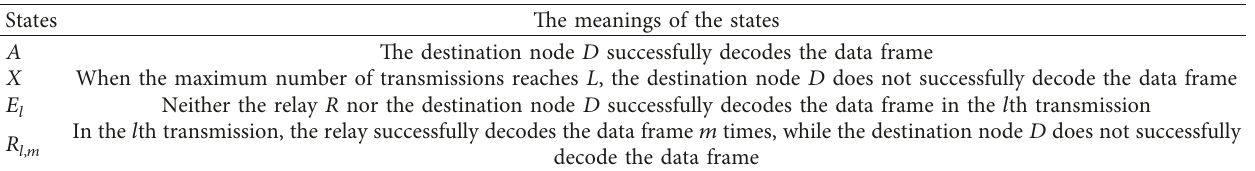
Table 1: The states of the DTMC